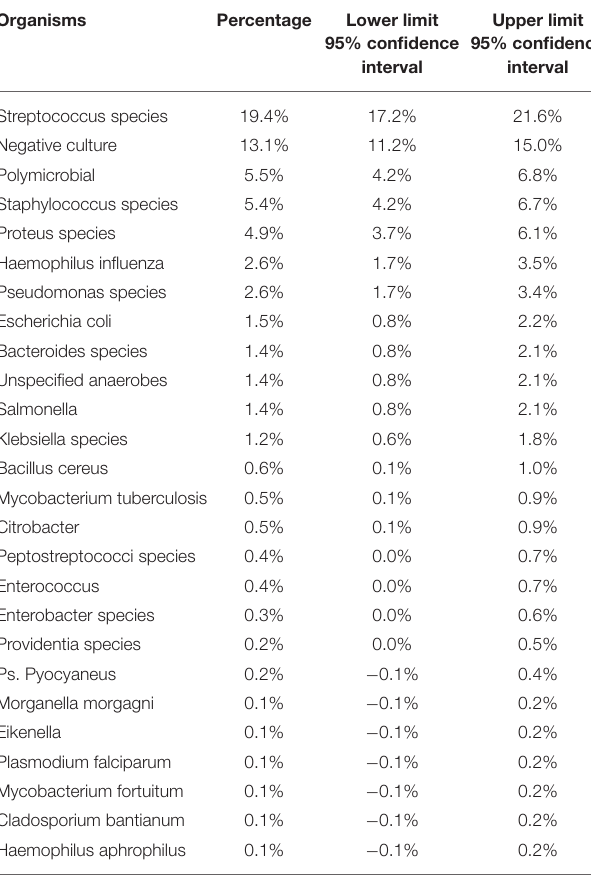
TABLE 3 | Management and outcomes of intracranial